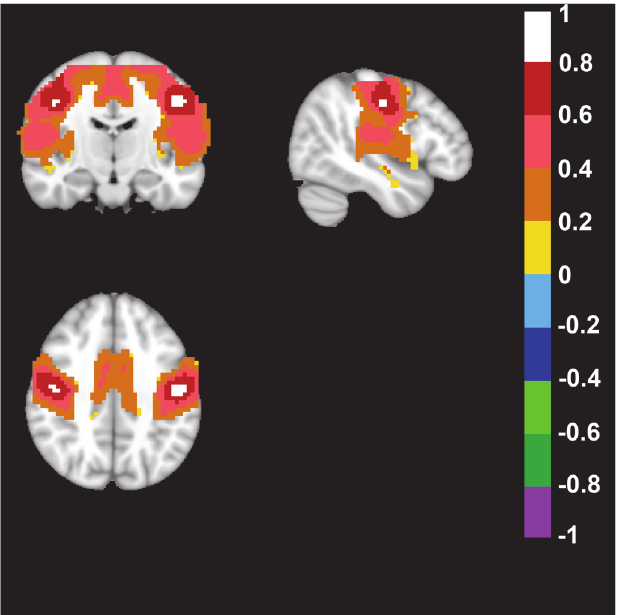
Fig 3. Human Motor Network. This network was derived from a bilateral seed placed in the Primary Motor Cortex region (Talairach coordinates in mm: +/-46; -13; 38). Top left image displays an axial, top right a sagittal and bottom image a coronal view of the human brain. Note the possitive FC-values of the primary motor cortex, somatosensory cortex and the supplementary motor area, the unilateral sagittal view of the motor cortex as well as the somatosensory cortex, and the coronal bilateral view of the primary motor cortex and the supplementary motor area. FC-values are displayed with a pseudo-colored scale bar; with increments of 0.2 each designated a color (see the color-bar in the image).